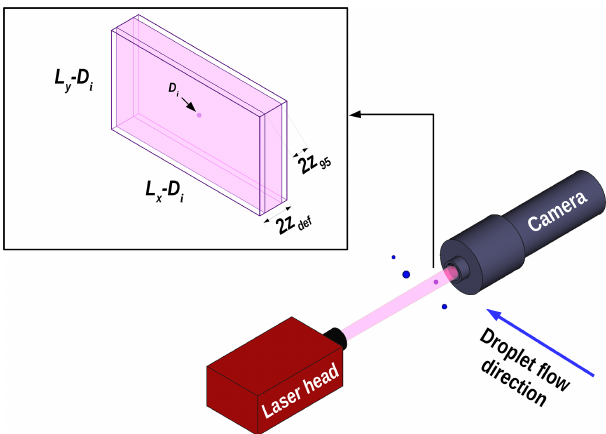
Figure 6. Schematic illustrating the difference between the default and the corrected/individual sample volumes with the same field of view S = (L x − D i )(L y − D i ) but different depths of field ( z def vs. z 95